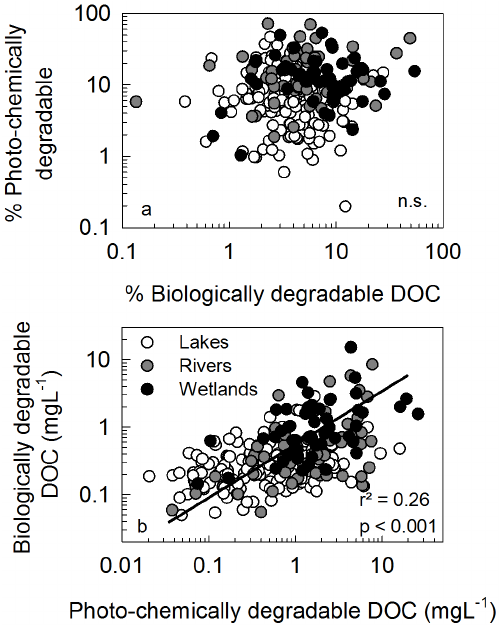
Figure 3. Relationship between the proportions (a) and amounts (b) of biologically and photochemically degradable DOC across boreal lakes, rivers and wetlands. (a) n = 262, not significant. (b) Lakes: log(BDOC) = 0.16log(PDOC) – 1.67, p = 0 . 0003, r 2 = 0 . 11, n = 161; rivers: log(BDOC) = 0.88log(PDOC) – 1.59, p < 0 .